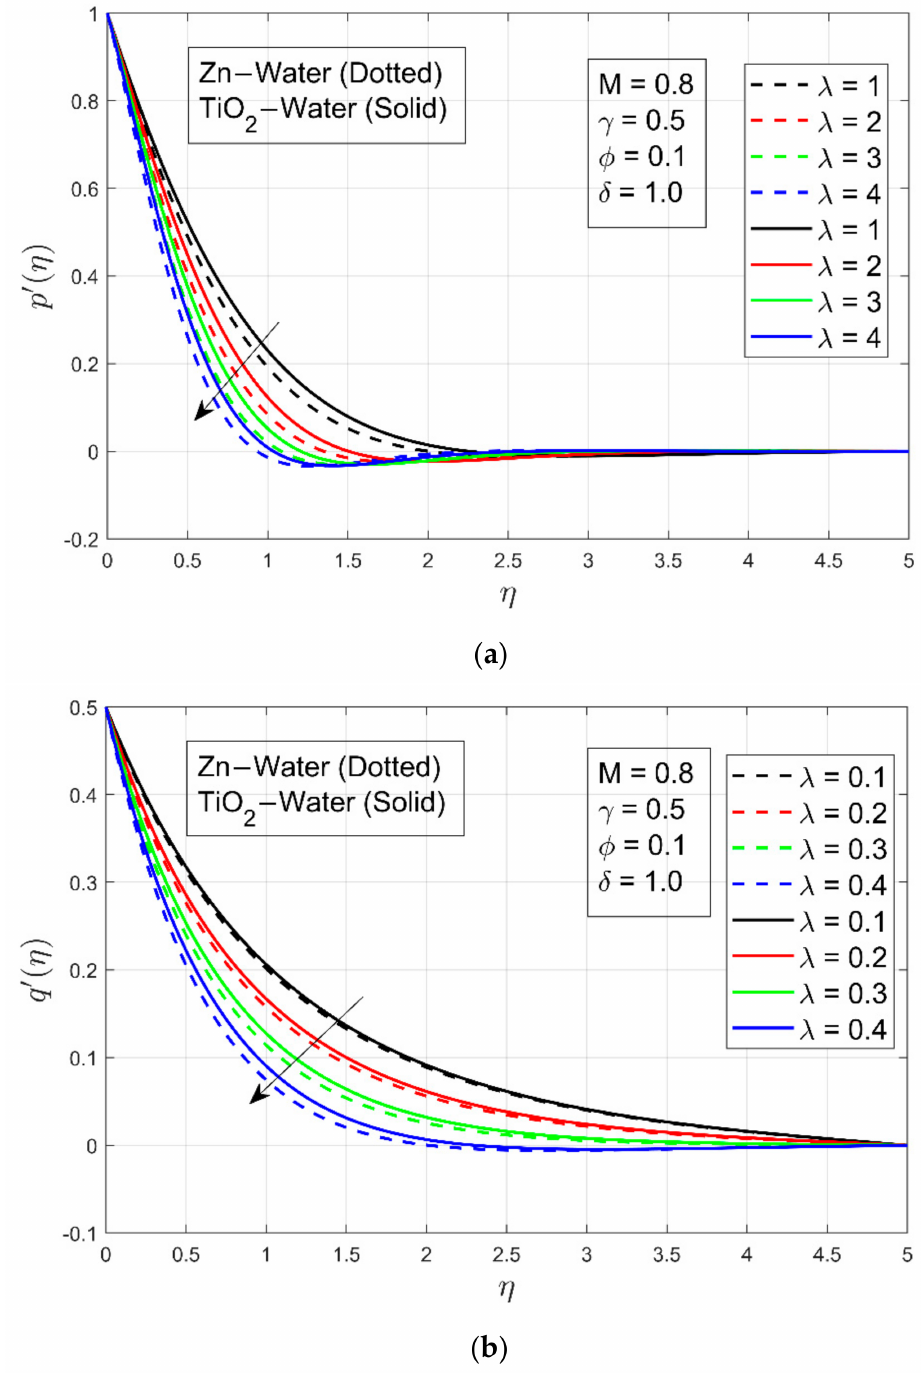
Figure 3. ( a ) The influence of rotation, λ , on p (cid:48) ( η ) , and ( b ) the influence of rotation, λ , on q (cid:48) ( η ) . Figure 4a,b show the impact of stretching ratio parameter, γ , on p (cid:48) ( η ) and q (cid:48) ( η ) . Physically, along the y -axis, as the rate of stretching ratio parameter γ increases, there is an increment in the rate of enlarging a , which infers an upsurge in velocity and thickness of the momentum boundary layer. The influence of stretching ratio in Figure 4a,b shows a very distinct pattern, as under high increasing stretching ratio, Figure 4a shows a